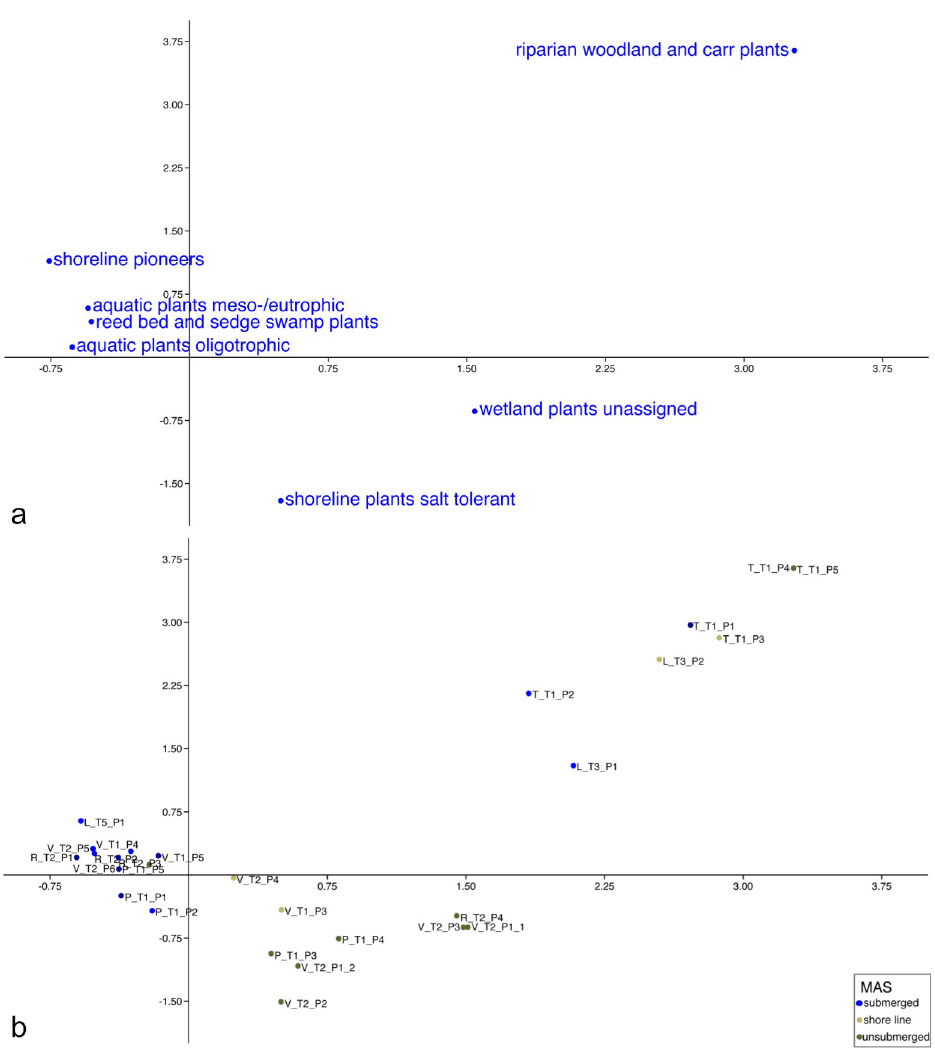
Fig 9. CA-graph based on density values of ecological groupings of aquatic and wetland plants in modern analogue samples. (a) Columns, (b) rows. Percentage of variation explained by the first two dimensions of CA: 58.1%.